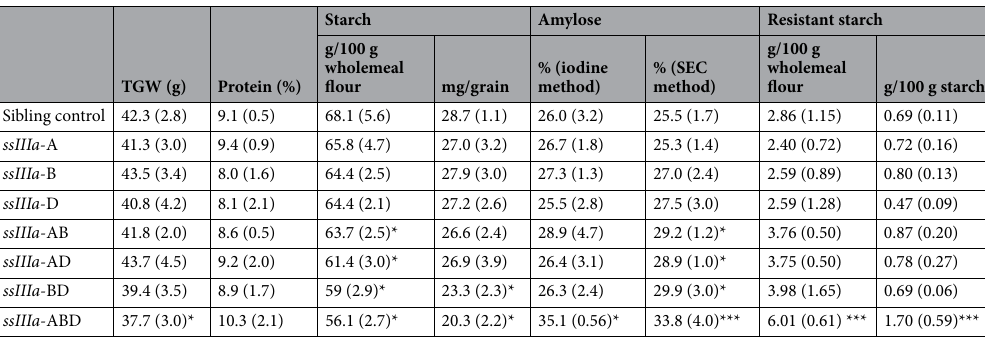
Table 2. TGW, protein and starch properties of mature grains of ssIIIa mutants and sibling control. Protein, starch and resistant starch contents of wholemeal flour were measured on a fresh weight basis. Starch content (mg/grain) was calculated using TGW values. Values represent the mean and (standard deviation) for n = 5 biological replicates (individual plants), except for TGW and protein which is for 5 ≥ n ≤ 13 biological replicates (sample sizes in Table S5). Statistically significant differences ( P < 0.05) identified in regression models comparing mutant genotypes to the sibling control are indicated with an asterisk